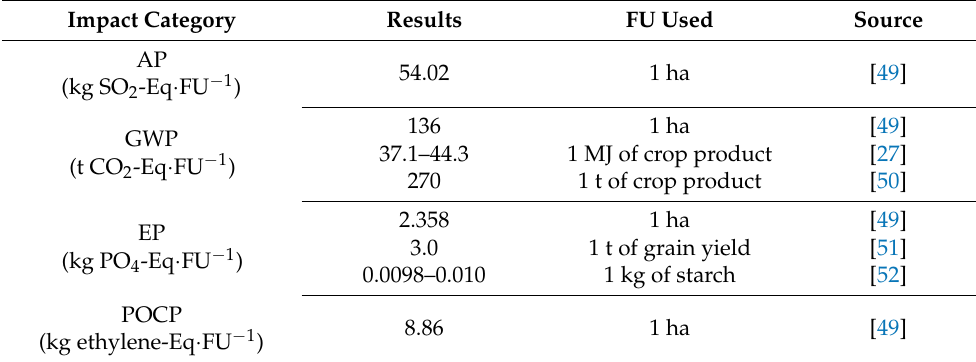
Table 1. Impact categories results of LCA analysis for barley crops from previous